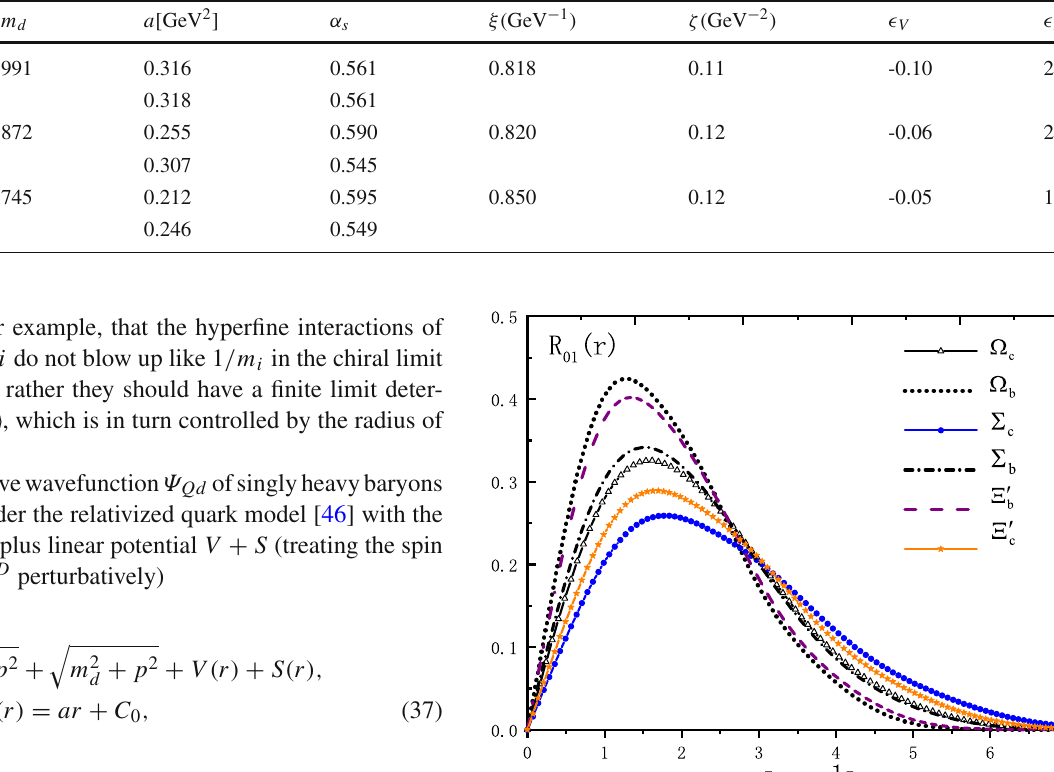
4480 MeV ( Q = b ) , and light diquark masses m d are taken from Ref. [38]. The confining potential parameter a is set by Regge trajectories of corresponding baryons, taken from Ref. [38] and Eq. (24) and Sect. 4